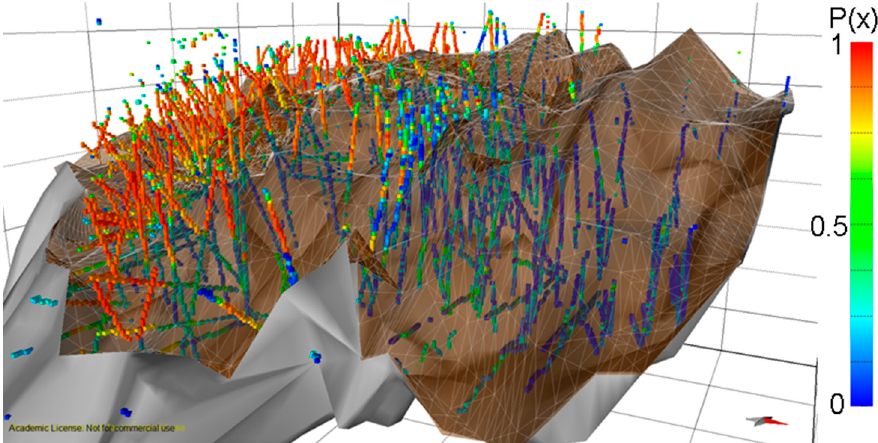
Figure 5. 3D view of a realization of P ( x ) at the locations of the boreholes. Red colors represent higher values of P ( x ) (massive ores at top), and blue-based colors refer to lower values of P ( x ) (stockwork ores at bottom).